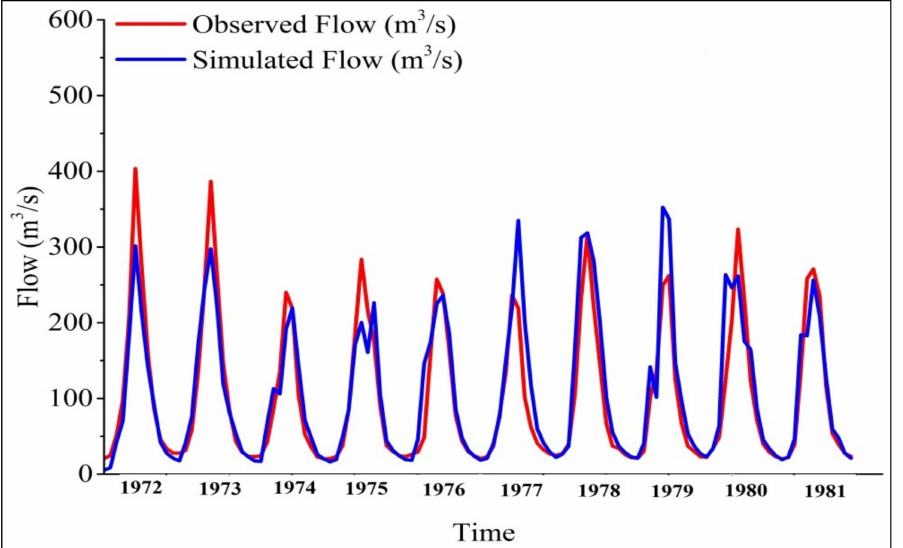
Figure 12. Model performance during the calibration stage.